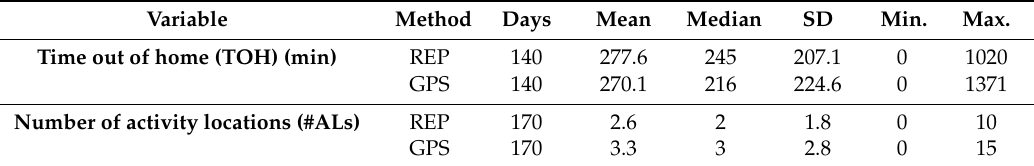
Table 3. Summary statistics for daily mobility indicators over all valid participant days.